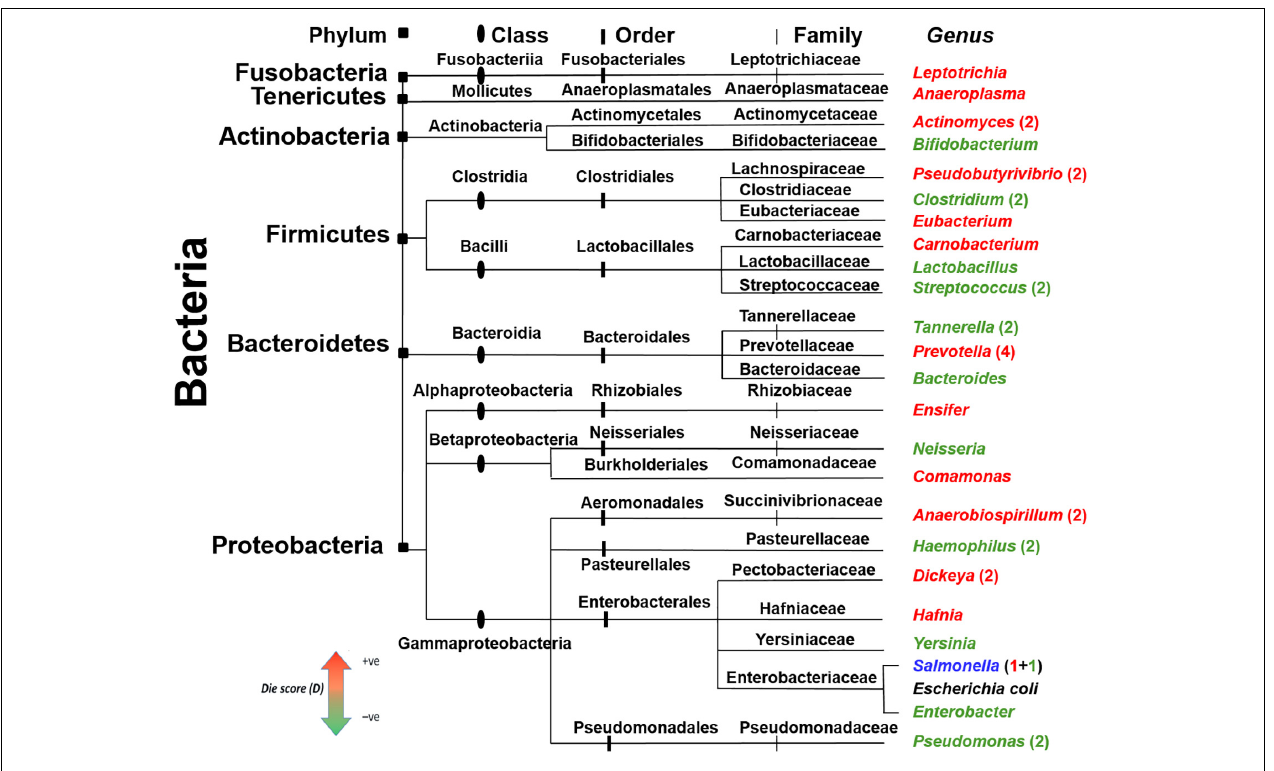
FIGURE 6 | Phylogenetic distribution of the bacteria with the maximum (red) and minimum (green) Die scores. Bacterial genera were taken from controls and disease data, Tables 2A,B and were colored according to their BW Die scores. The taxonomic division for the different genera is shown on top and depicted as notches of different shapes on the ancestry lines. Escherichia coli (black color text) is included for comparison. Genera without numbers represent single observations from Tables 2A,B . When present, numbers represent more observations. Salmonella (blue) acquired low and high Die scores in two different